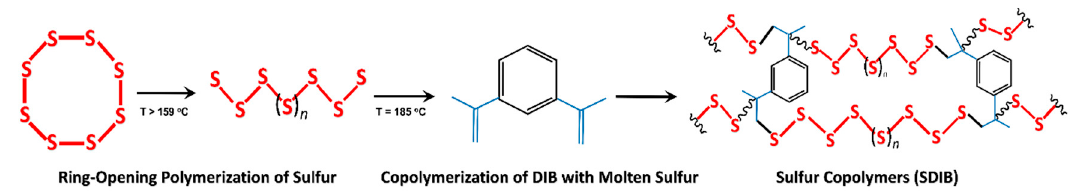
Figure 1. Schematic representation of sulfur copolymers (SDIB) produced via inverse vulcanization of S 8 with 1,3-diisopropenyl benzene (DIB).